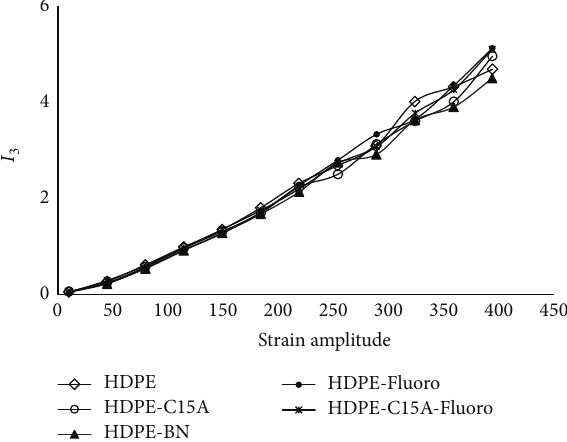
Figure 4: Relative phase angle of the third harmonic as a function of strain amplitude at 200 ∘ C for HDPE, HDPE-C15A, HDPE-BN, HDPE-Fluoro, and